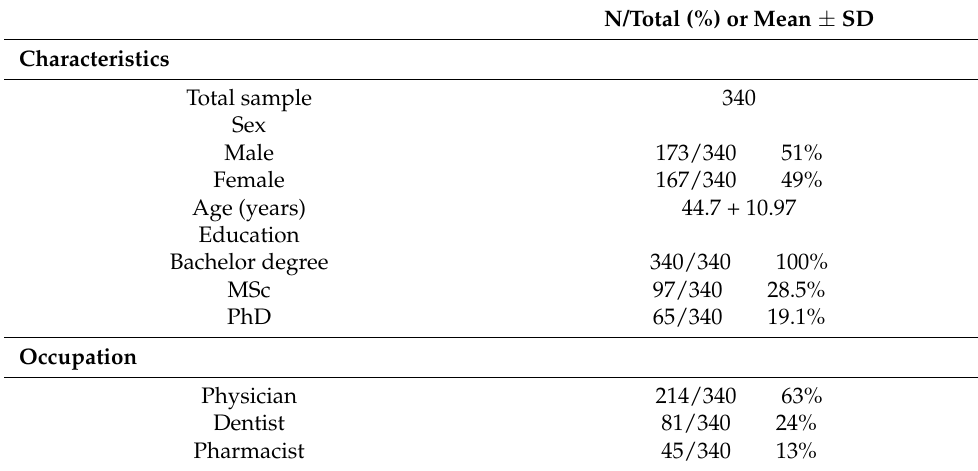
Table 1. Demographic characteristics of the health care